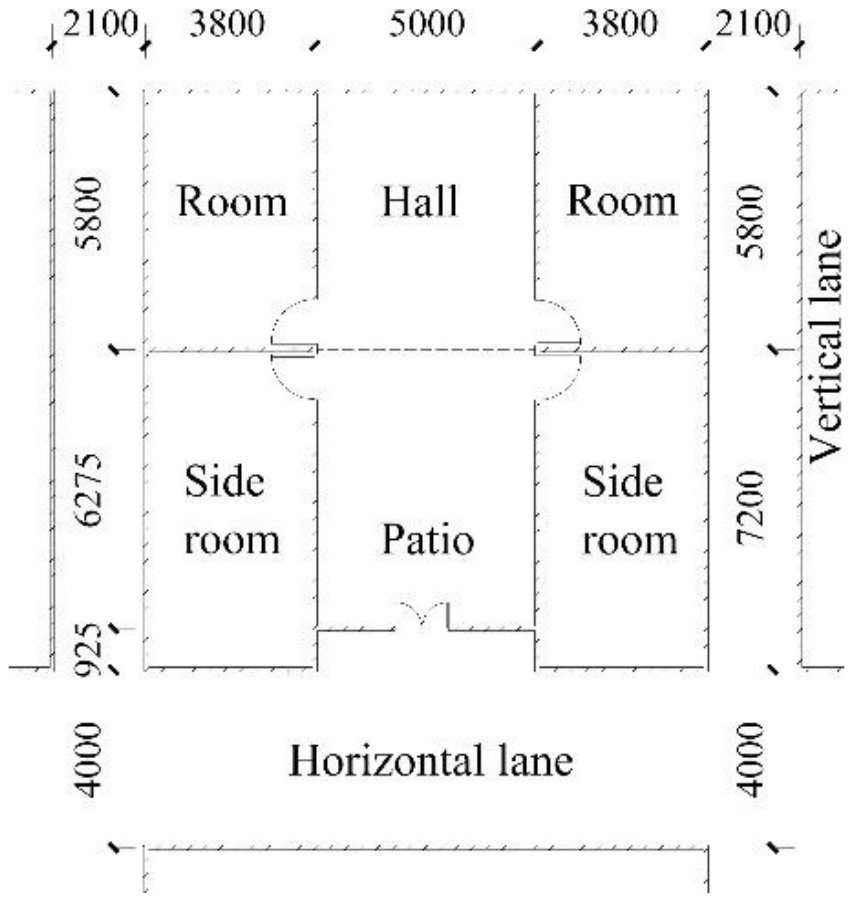
Figure. 12 The plane dimensions of the application